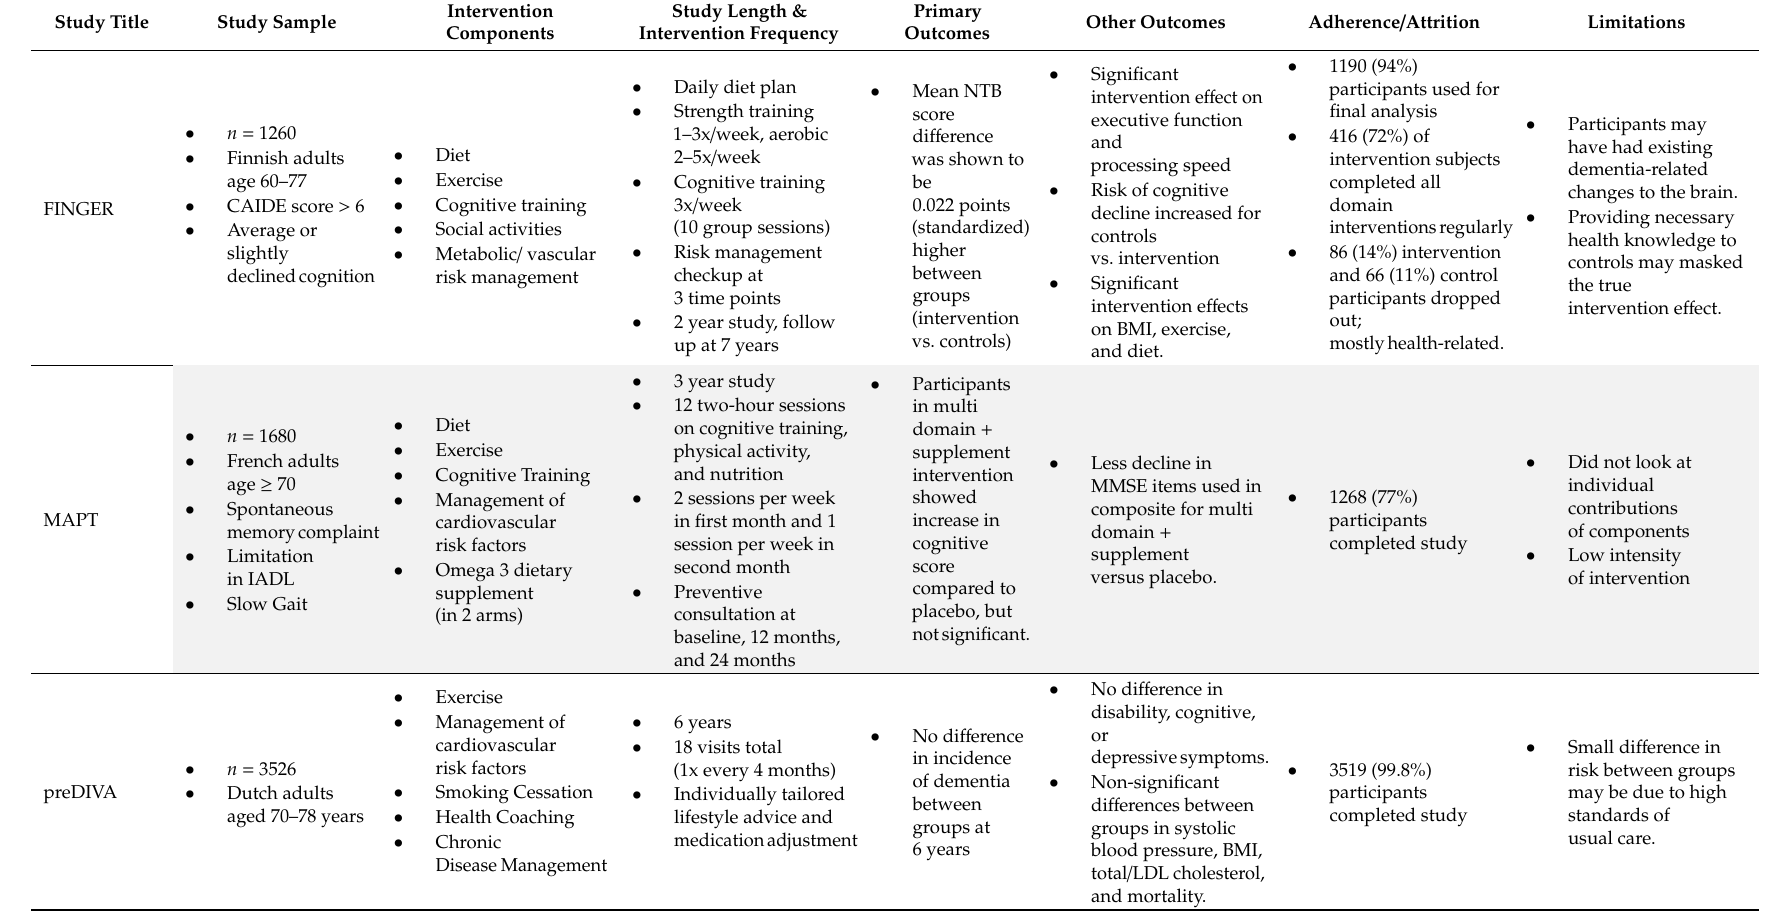
Table 1. Completed Face-to-Face multidomain interventions to enhance cognitive reserve and reduce risk of Alzheimer’s disease and related dementias